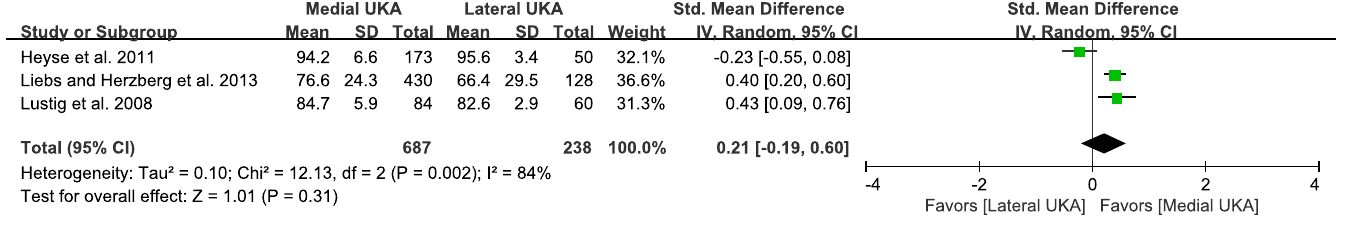
Fig 4. Results of aggregate analysis for comparison of function scores between patients with medial and lateral UKAs.